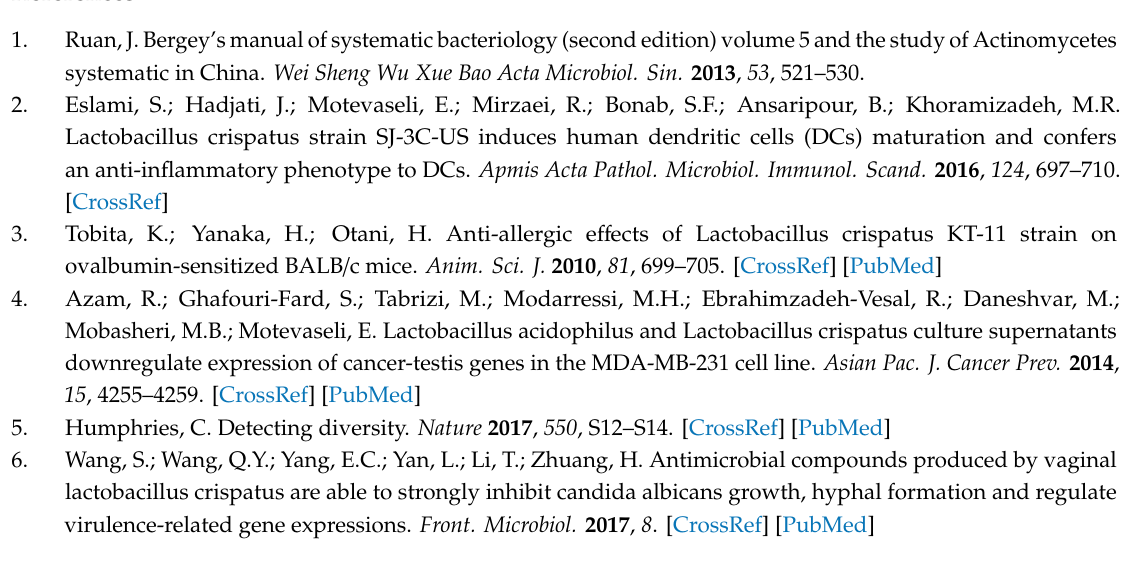
Table S1: Higher abundance of 38 genes in the vagina, Table S2: Higher abundance of 31 genes in the